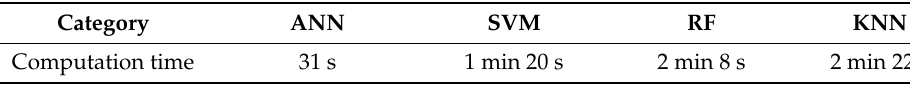
Table 9. Computation time of prediction